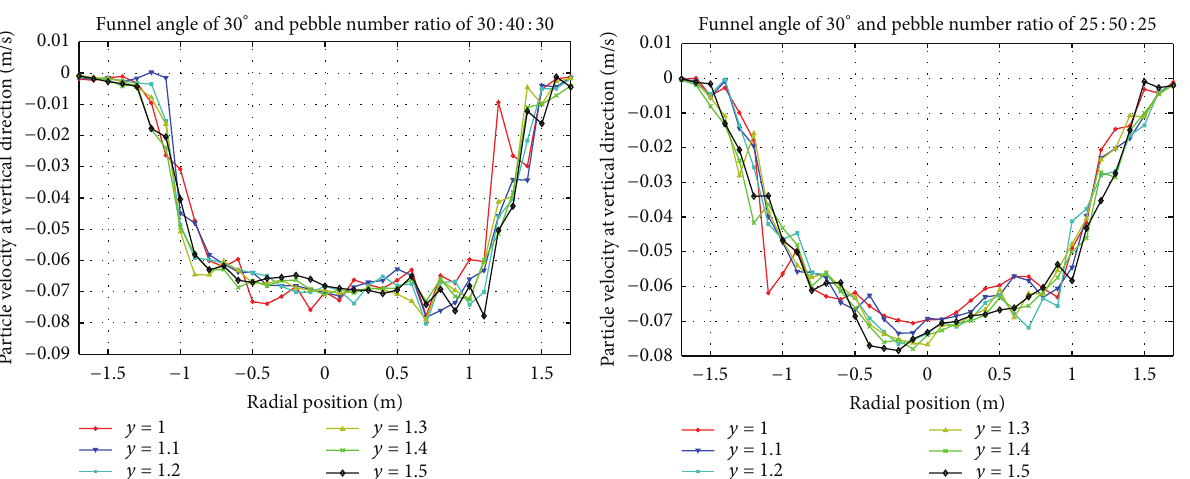
(a) Vertical velocity distribution of pebbles with number ratio 30:40:30 at upper region Funnel angle of 30 ∘ and pebble number ratio of 30 : 40 : 30